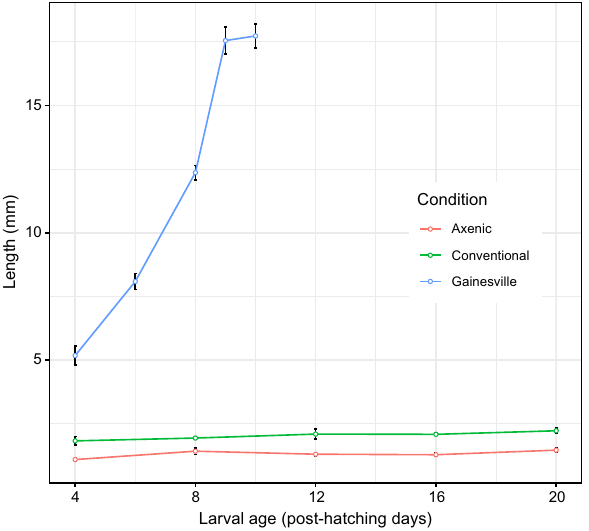
Figure 1. Length of larvae reared on Gainesville or BHI. Total larval (N = 10) length variation on a period of 20 days (day 1 = hatching), of larvae reared in axenic (red) and conventional (blue) conditions and fed with BHI culture media and larvae from parent colony (green) fed with Gainesville feed (27 ̊ C, RH 70% and 12:12 light